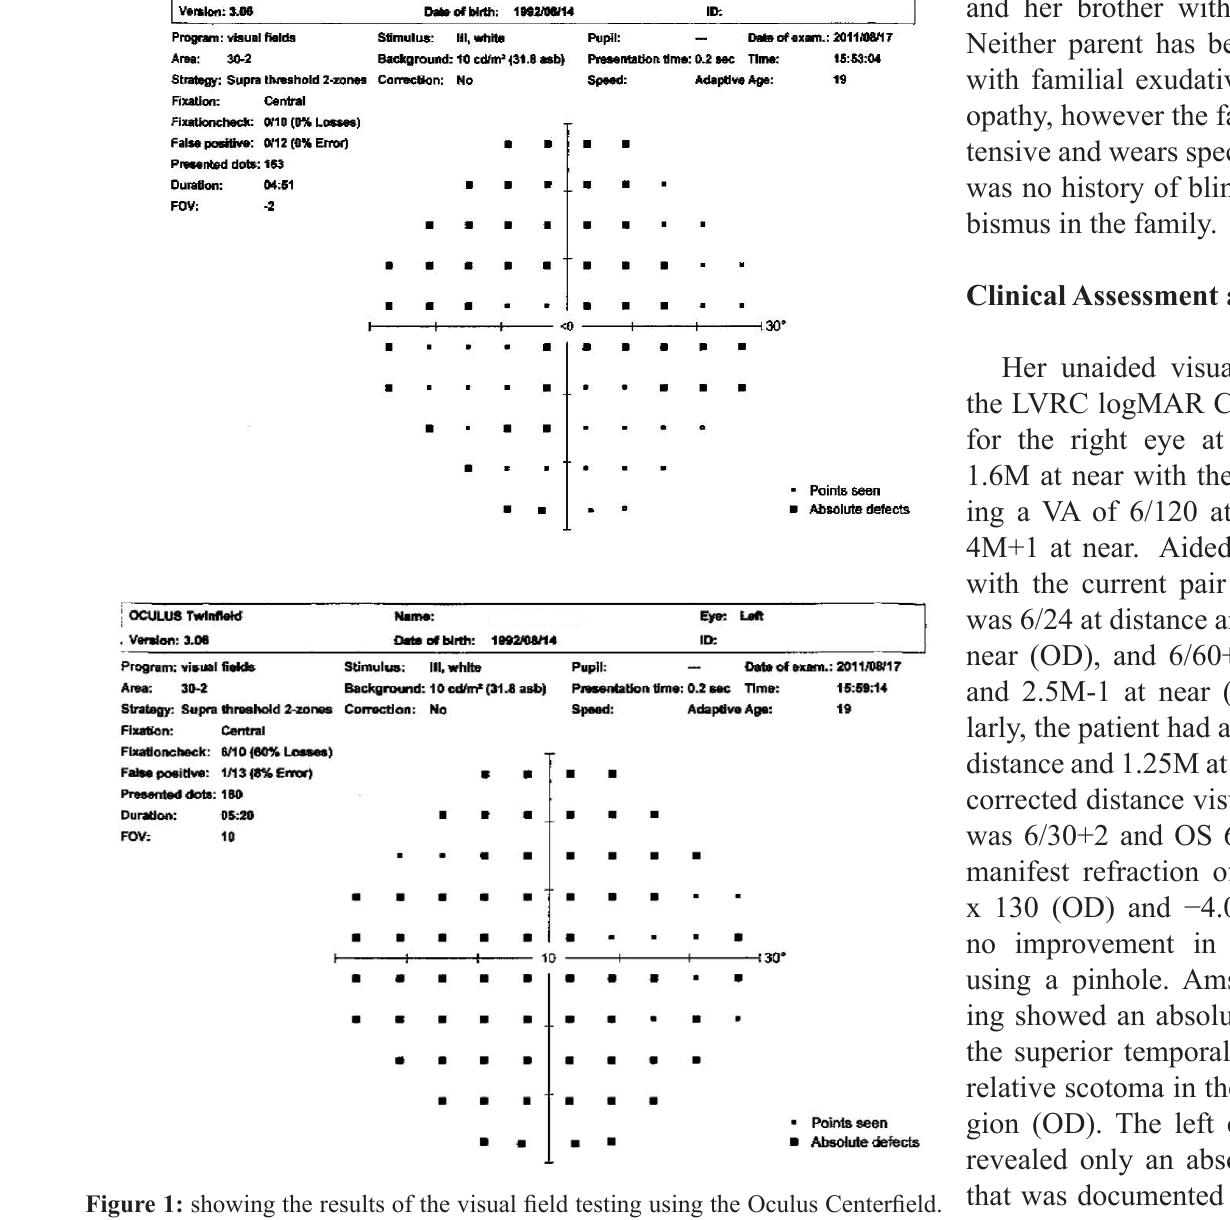
Figure 1: showing the results of the visual field testing using the Oculus Centerfield. Markedly restricted visual fields in both